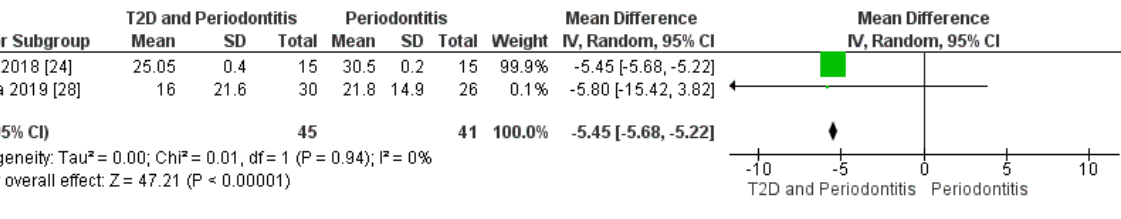
Figure 5. Forest plot for the IL-4 plasma levels of the periodontitis and the diabetes plus periodontitis